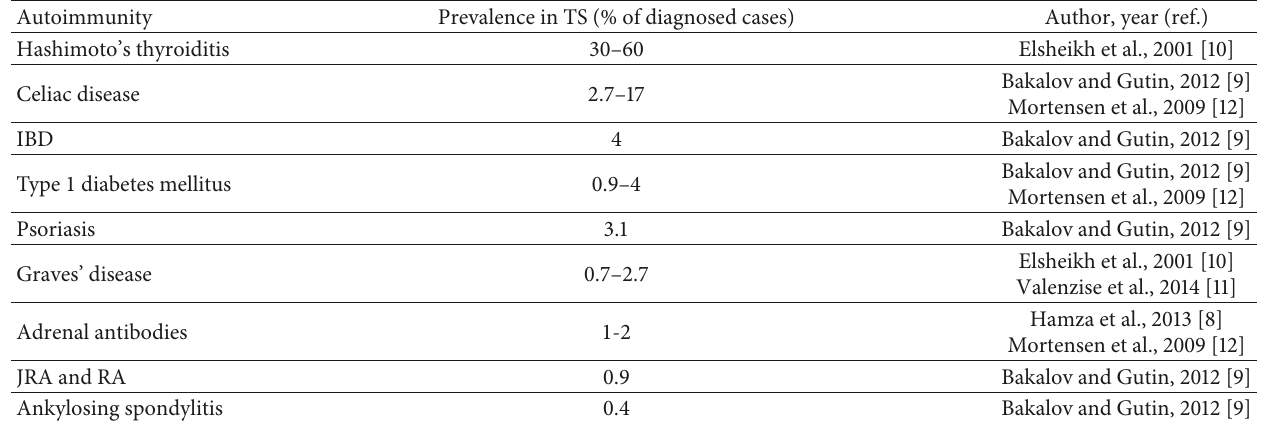
Table 1: Estimated prevalence of autoimmunity in Turner syndrome.